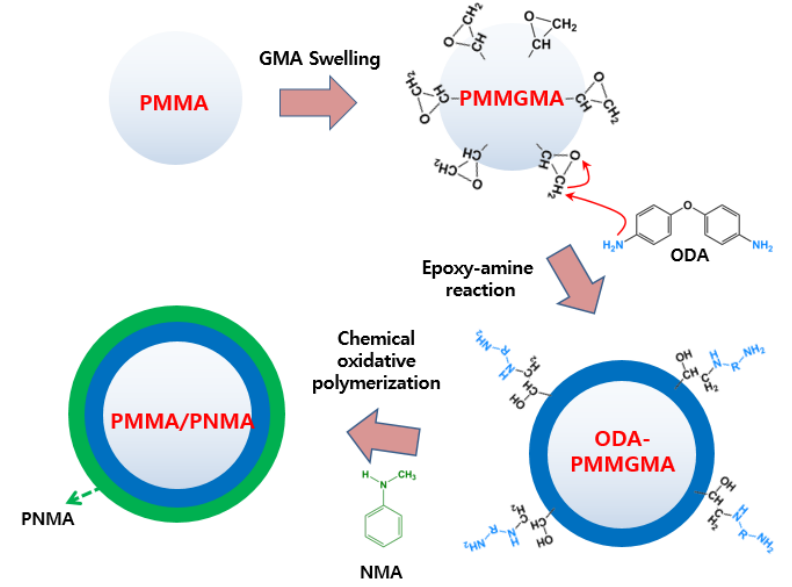
Figure 1. Schematic diagram illustrating the experimental route used to fabricate Semi-conducting PMMA/PNMA